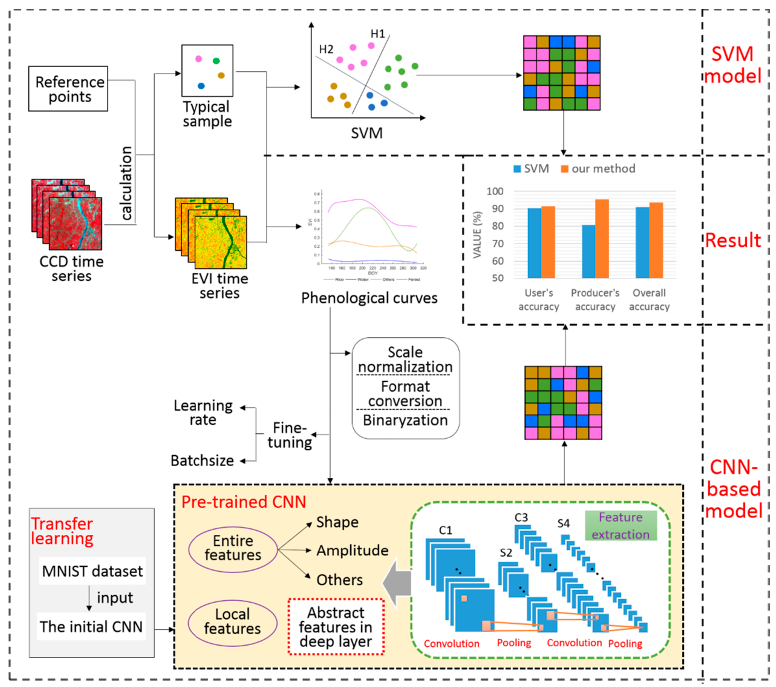
Figure 2. Workflow of rice mapping based on the support vector machine (SVM) and proposed method.